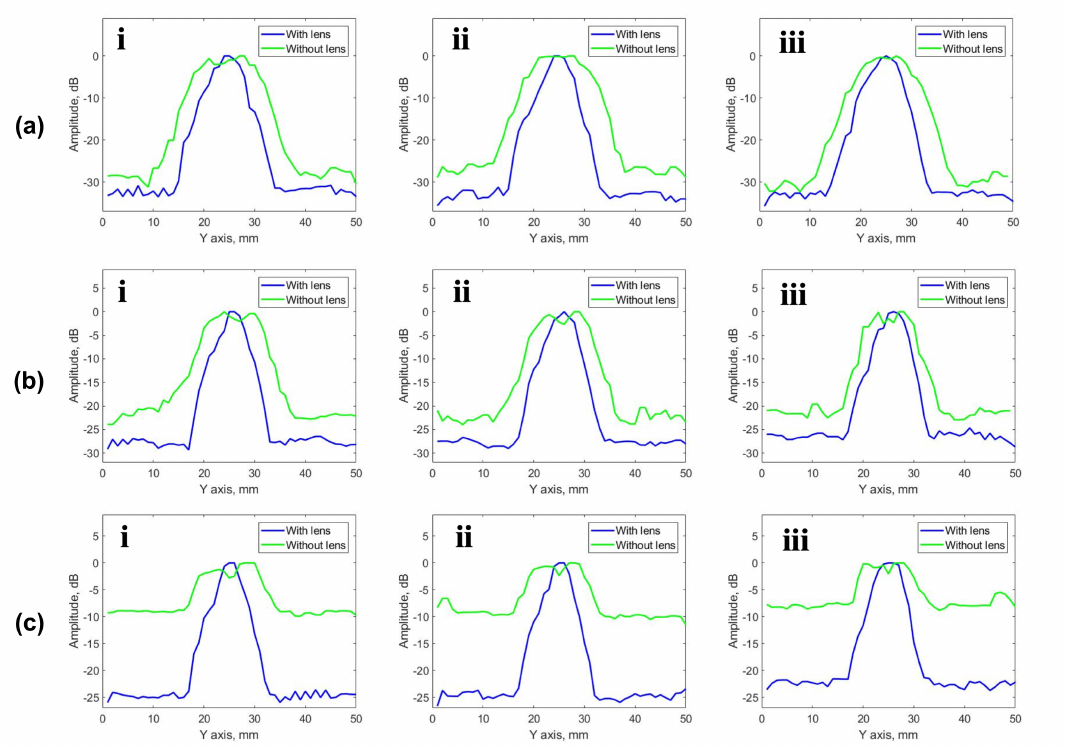
Figure 11. Lateral profiles of result obtained for blocks ( a ) A, ( b ) B, and ( c ) C, on the Y axis for each of the flaw: i—depth of the drilling 15 mm; ii—depth of the drilling 20 mm; iii—depth of the drilling 25 mm.